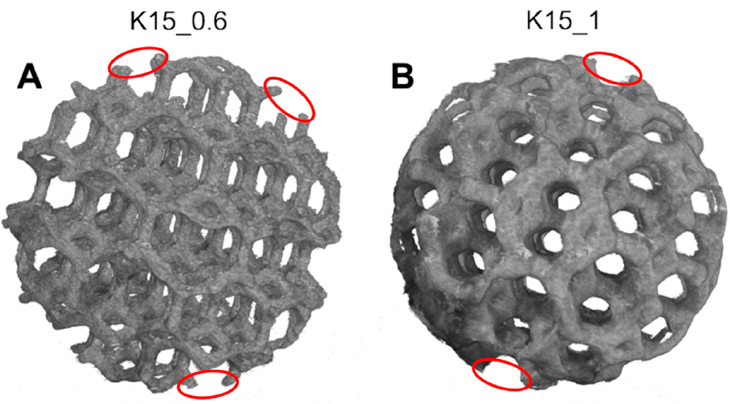
Figure 12. Models rebuilt by XmCT of the PBF K-type beads: ( A ) 0.6 mm strut diameter and ( B ) 1 mm strut diameter. Several defects are visible.